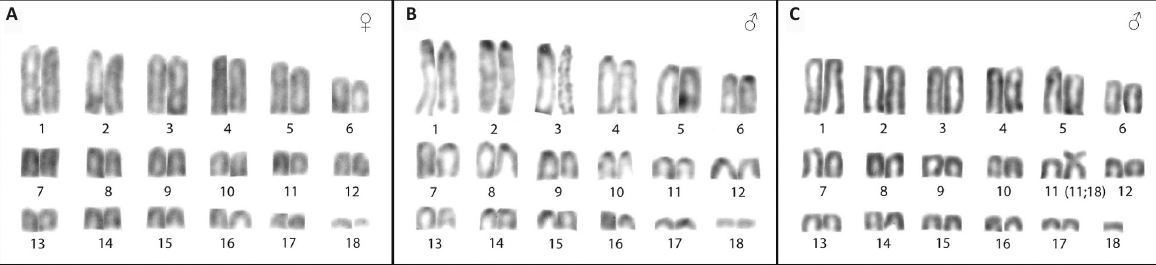
Image 6. Conventionally Giemsa-stained mitotic chromosomes of (A) female and (B, C) male Pristimantis nubisilva sp. nov . The karyotype of the male depicted in (C) shows a heterozygous centric fusion between chromosomes 11 and 18, resulting in a submetacentric fusion